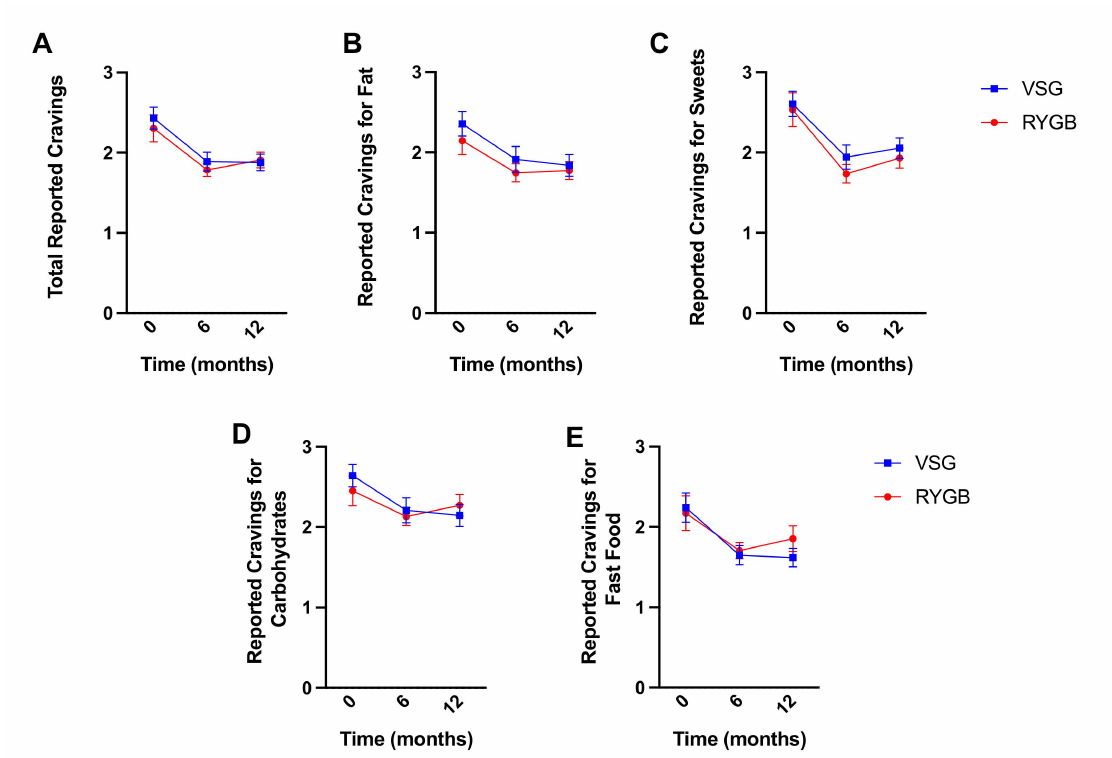
Figure 7. Mean ± SEM self-reported scores on the FCI for ( A ) total cravings, ( B ) fat cravings, ( C ) sweet cravings, ( D ) carbo- hydrates/starch cravings, and ( E ) fast food cravings at baseline, six months, and one year following RYGB (red circles) and VSG (blue